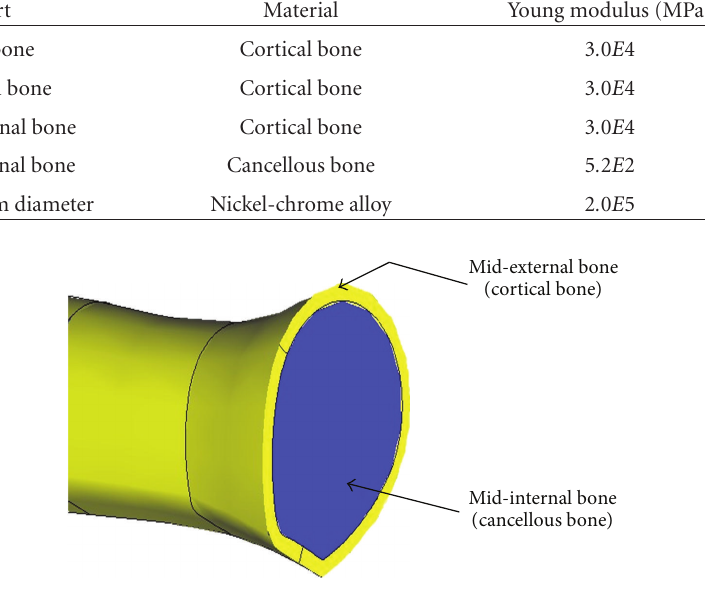
Figure 5: Main parts of mid-solid model of humerus bone.